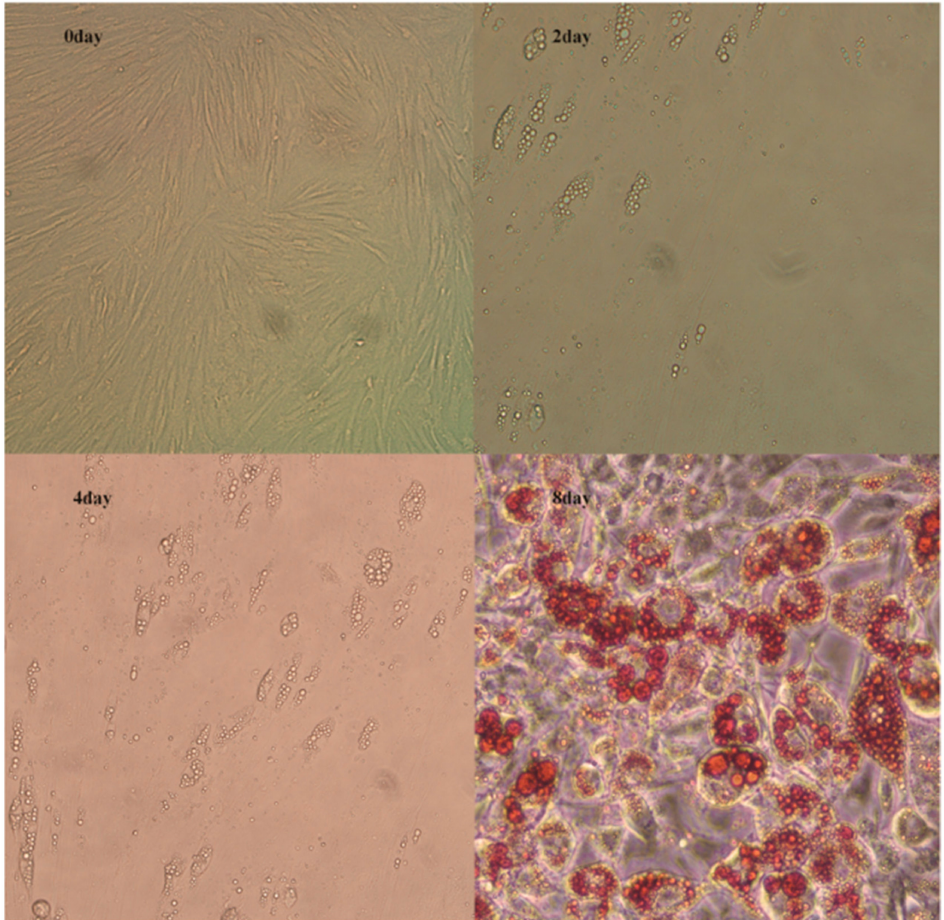
Figure 1. In vitro adipocyte di ff erentiation. Adipocytes were obtained from the subcutaneous adipose tissue of three seven-day-old Landrace pigs and collected at four di ff erentiation stages: day 0, day 2, day 4, and day 8. Enlarged adipocyte photos during the di ff erentiation (day 0, day 2, day 4, day 8; day 8 with Oil Red O staining (20 ×